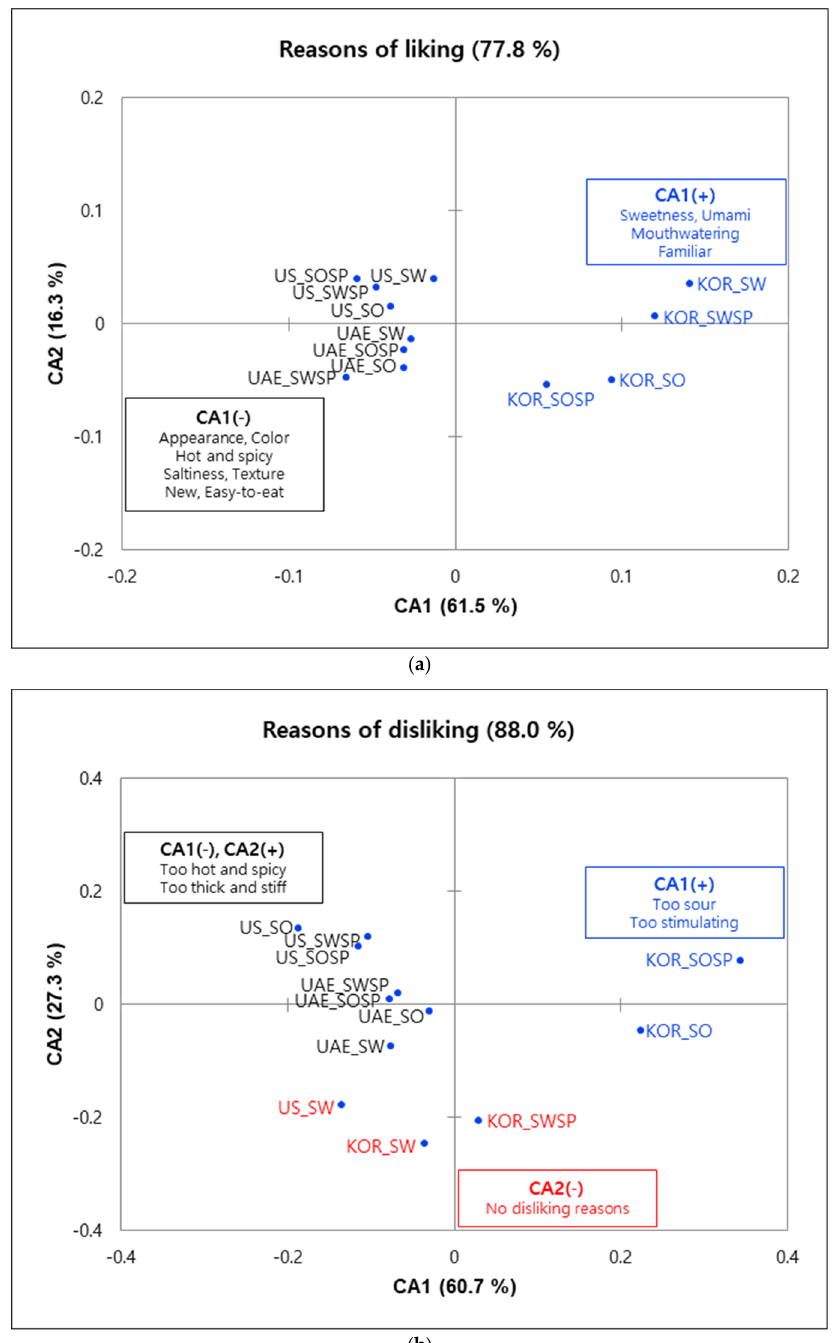
Figure 4. Correspondence analysis plot of ( a ) reasons for liking attributes and corresponding dipping sauce sample loadings; ( b ) reasons for disliking attributes and their sample loadings. Blue dots indicate the sample loadings evaluated by the consumers in the three countries and attributes in the boxes refer to the CATA liking and disliking terms.